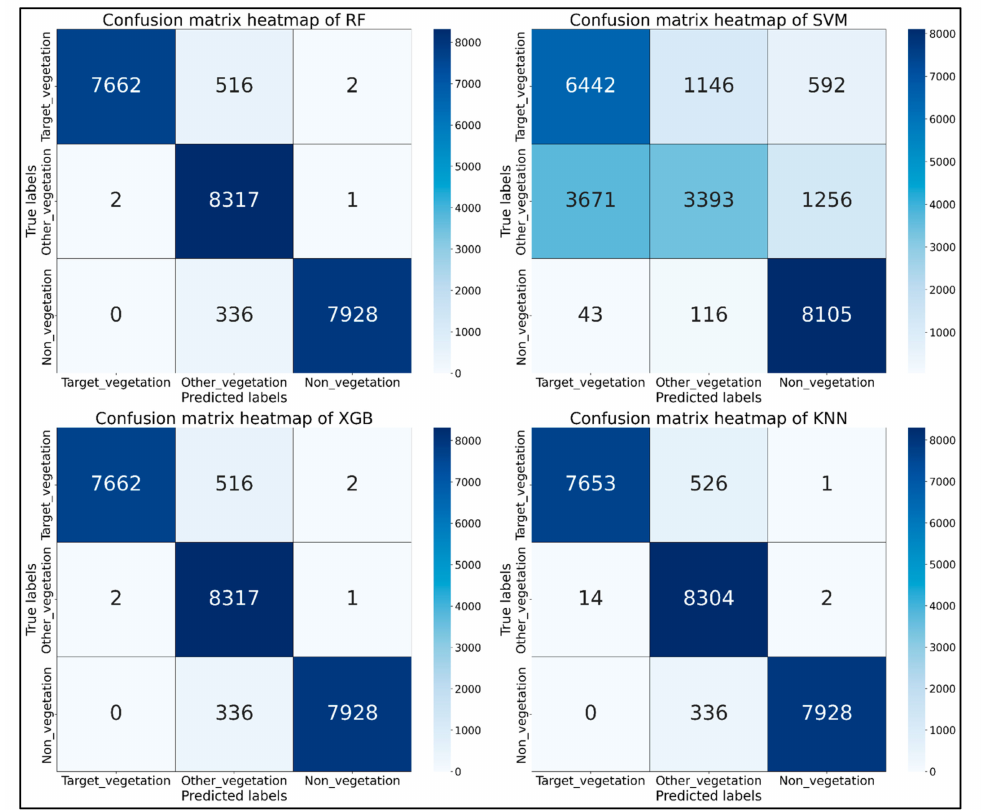
Figure 12. Confusion matrix for training of different machine learning models for foliage